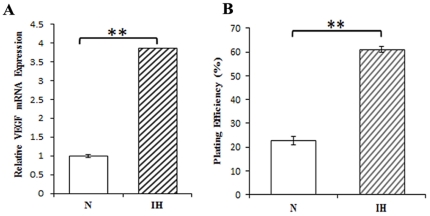
Effects of intermittent hypoxia on VEGF, a hypoxia-response gene and cell survival.(A) Real-time PCR. Total RNA was extracted from normoxic (N), and intermittent hypoxia (IH) conditioned neuroblastoma cells using Trizol and cDNA was generated by reverse transcription. Real-time PCRs were done to measure VEGF gene transcript. **P<0.01, intermittent hypoxia versus normoxia. (B) Clonogenic assay. Cells were trypsinized, plated into 100-mm dishes, and incubated at 37°C in a humidified incubator containing 5% CO2. After 15 days, cells were stained with crystal violet and colonies having >50 cells were counted as surviving colonies. **P<0.01, intermittent hypoxia versus normoxia.